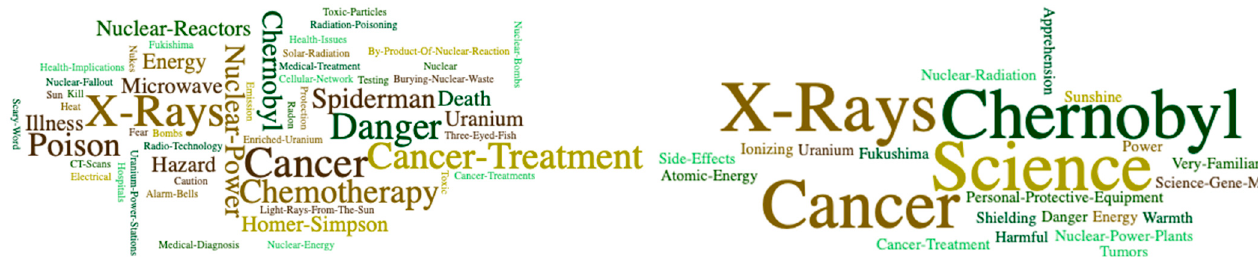
Figure 5. General population focus groups ( left ) and radiation workers ( right ) word cloud.